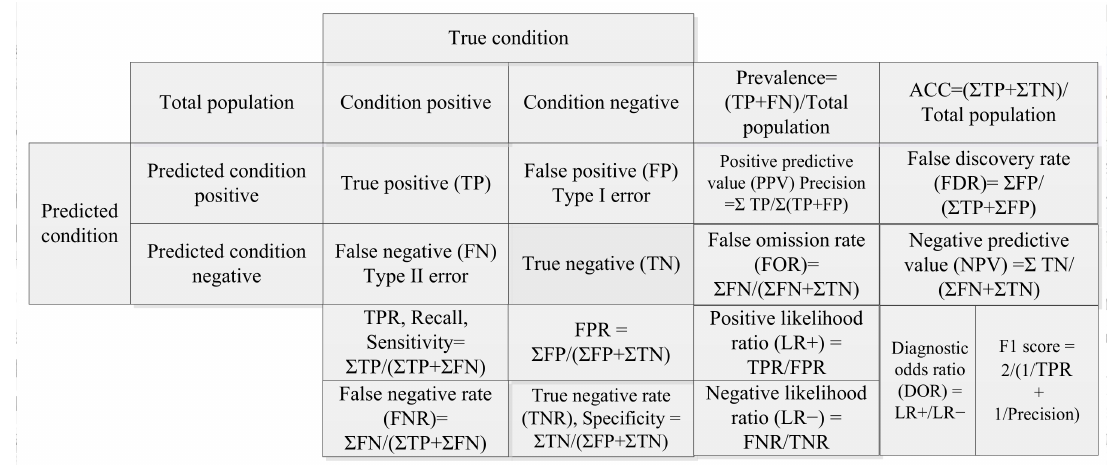
Figure 2. The confusion matrix and performance indicators for classification